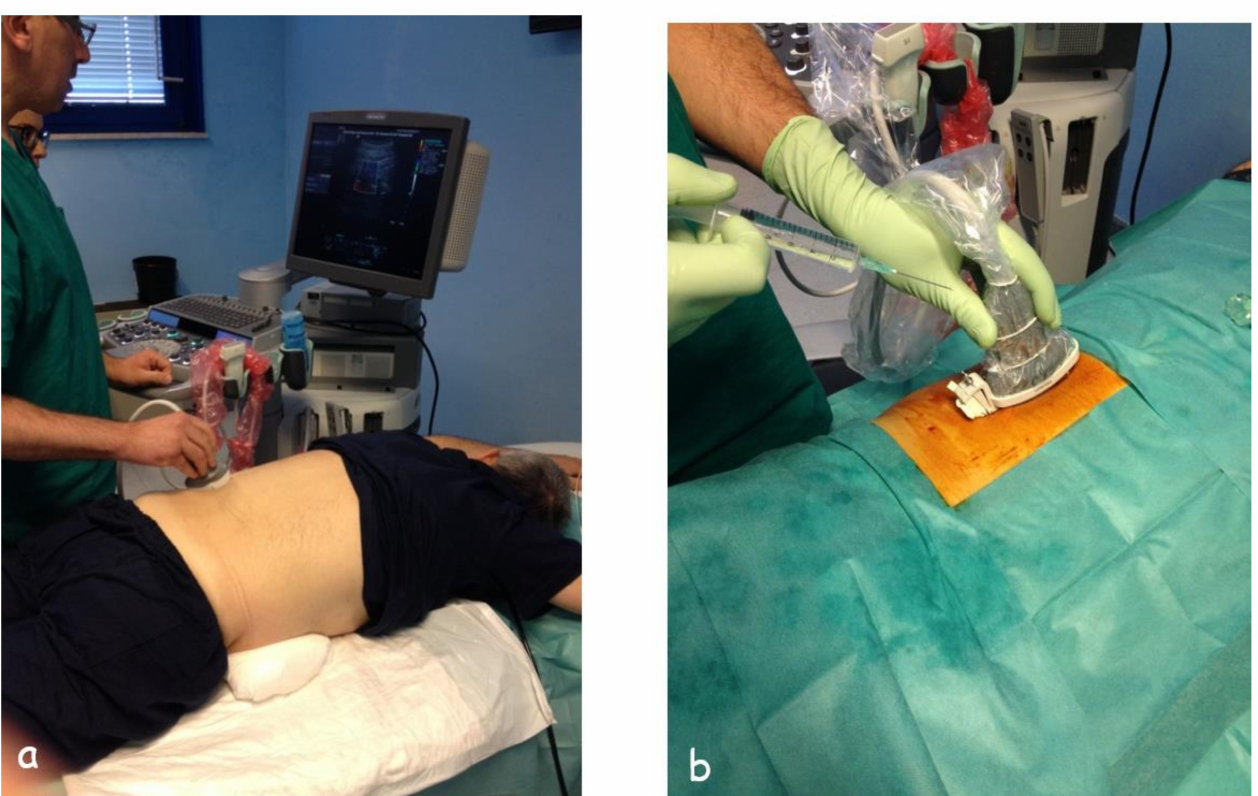
Figure 4. ( a ) Demonstration of the correct position of a patient undergoing a renal biopsy in prone position, the position in which the biopsy is performed must also be maintained during the ultrasound examination, and ( b ) the same patient after the preparation of a sterile field and application of the drapes, just before the injection of the